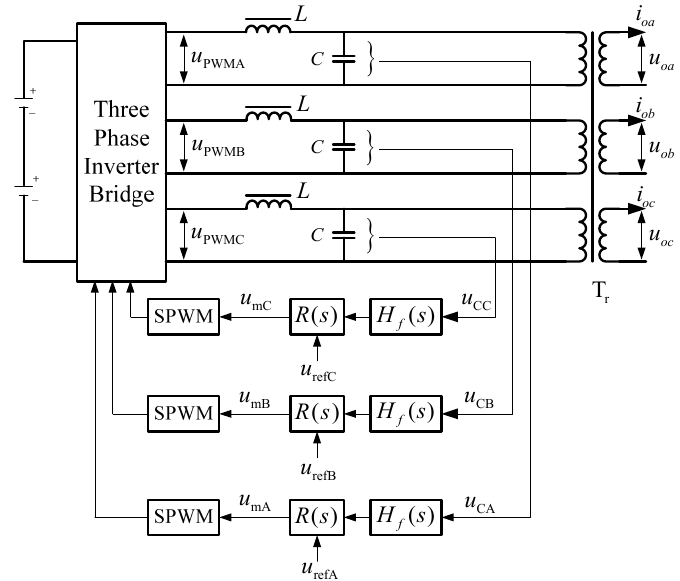
Figure 6. A three-phase inverter with PID closed-loop